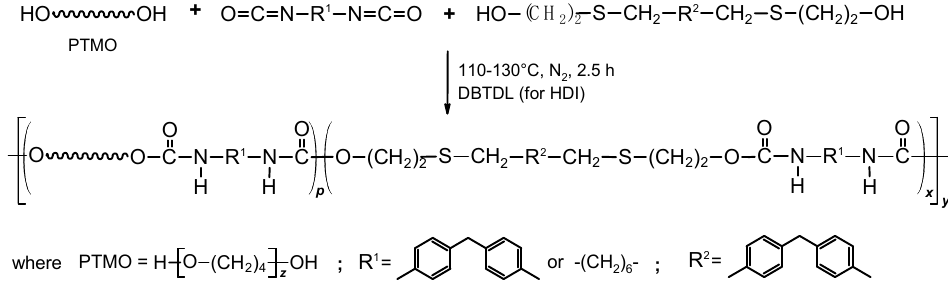
Figure 1. Schematic representation of the synthesis route of TPU elastomers.